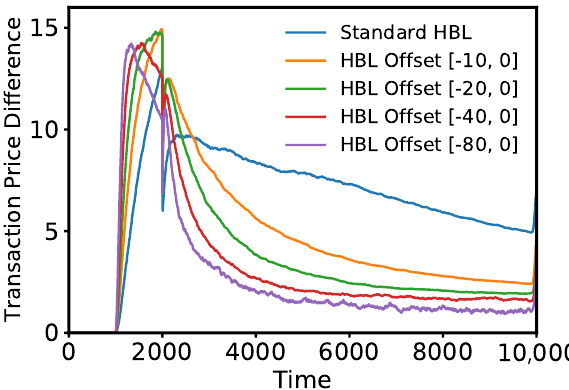
Figure 16. Average HBL surplus differences and total number of transactions in non-spoofing markets where HBL traders use different price offsets.